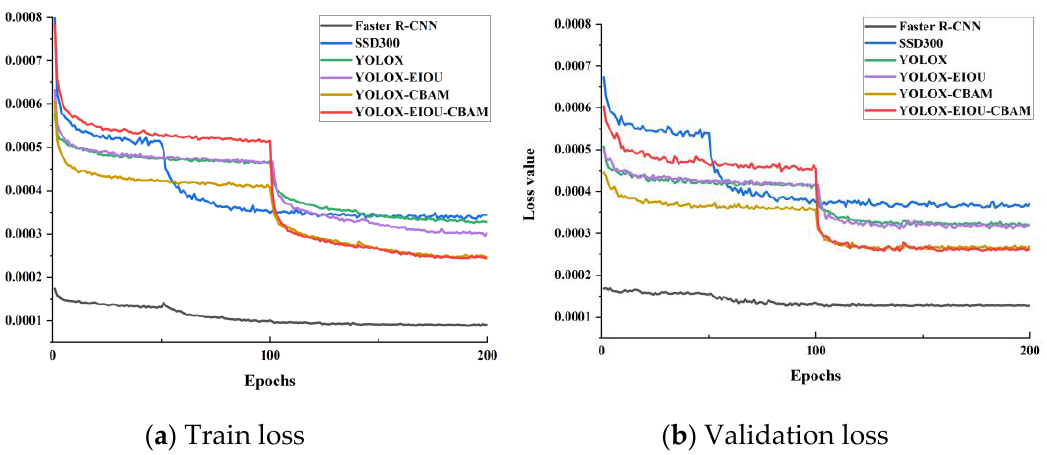
Figure 7. The training loss curve and the validation loss curve for six models (Faster R-CNN, SSD300, YOLOX, YOLOX-EIoU, YOLOX-CBAM, YOLOX-EIoU-CBAM). ( a ) Train loss curve. ( b ) Validation loss curve.